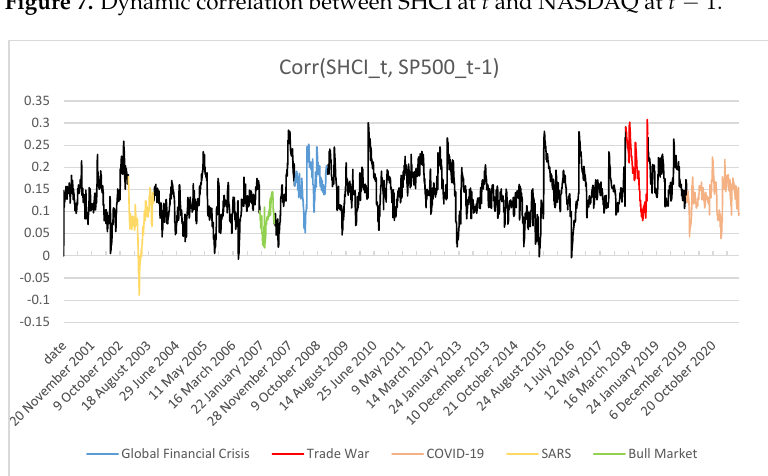
Figure 8. Dynamic correlation between SHCI at t and SP500 at t - 1.